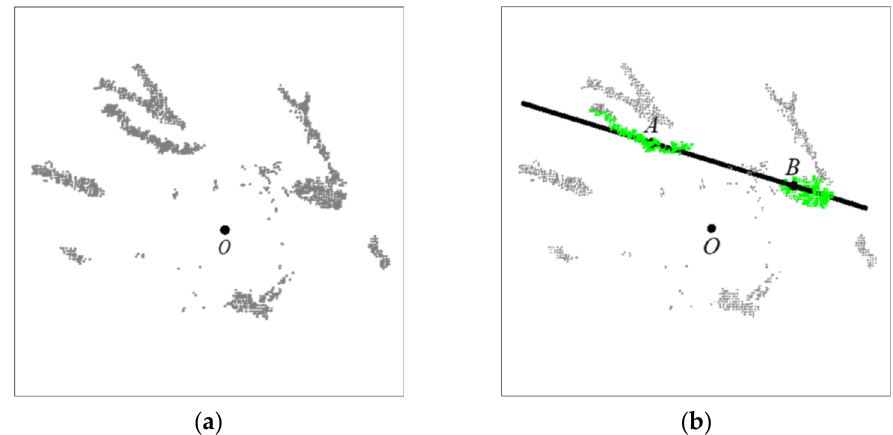
Figure 9. The straight line fitting point cloud in the neighborhood of the target apple: ( a ) point cloud M inter in the branch detection space (i.e., with the sphere points removed); ( b ) straight line fitting. The green point cloud in is the point cloud for the branch closest to the centroid O fitted by RAN-SAC.